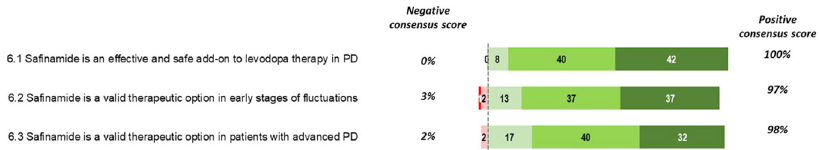
Fig. 6 Delphi questionnaire results: topic 6 “ Target Population ” . Numbers in the colored bars are the total number of votes received for each level of disagreement/agreement (1, extremely disagree; 2, disagree; 3, agree; 4, mostly agree; and 5, extremely agree). The “ negative consensus score ” and the “ positive consensus score3 are